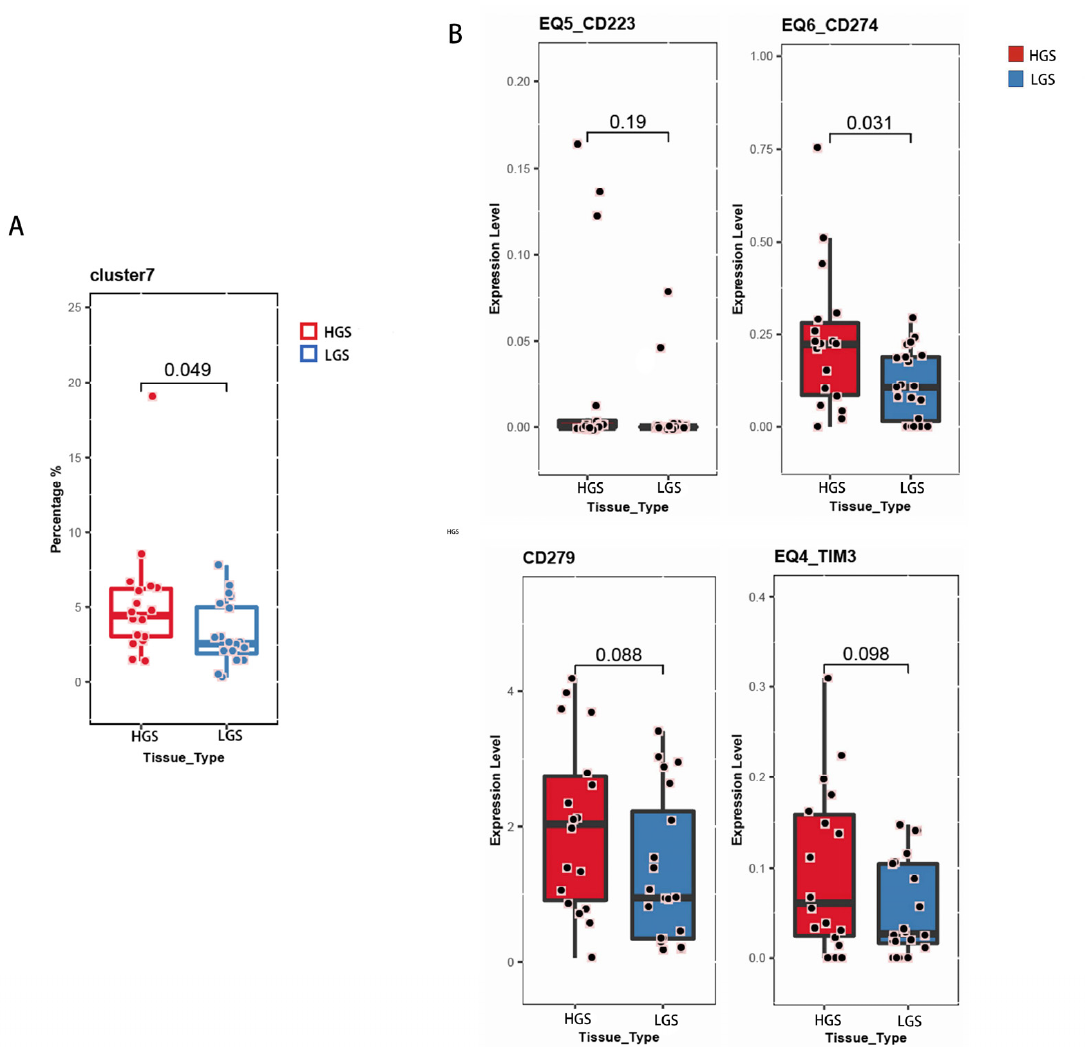
Figure 7. ( A ) Box plots of proportions of all CD4+ T cells that were Th17 cells in carcinoma tissues from patients with moderate-to-severe or mild inflammation and fibrosis. ( B ) Box plots showing expression of PD-L1 in CD8+ T cells in carcinoma tissues in patients with moderate-to-severe or mild inflammation and fibrosis.